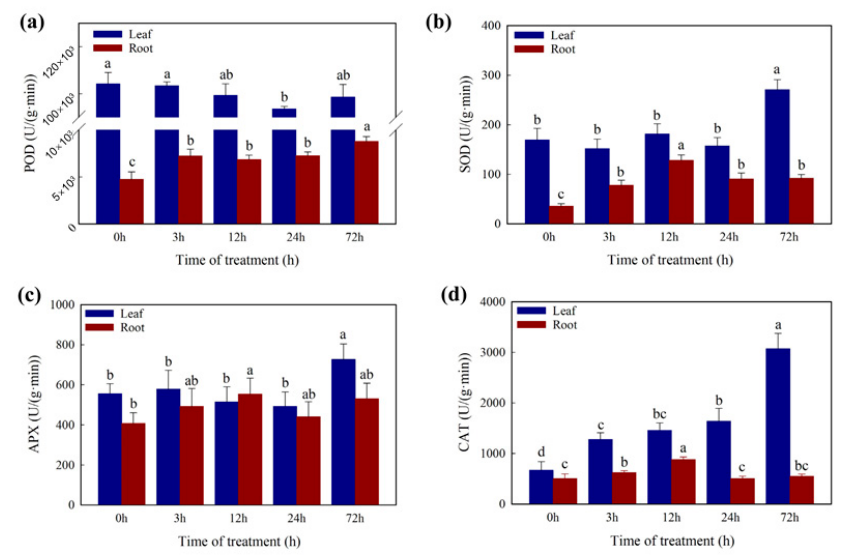
Figure 4. Measurement of antioxidative enzyme activity ( a ) POD activity, ( b ) SOD activity, ( c ) APX activity, ( d ) CAT activity. Different letters (a–d) in the figures indicate significant differences at p < 0.05 level among different time points in the same tissue.